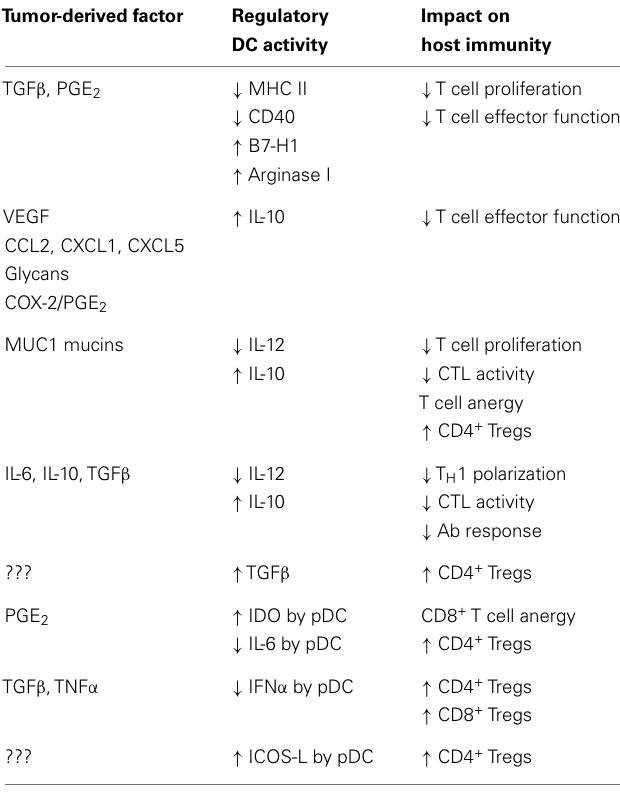
Table 3 | Induction and suppressive activity of tumor-associated regulatory